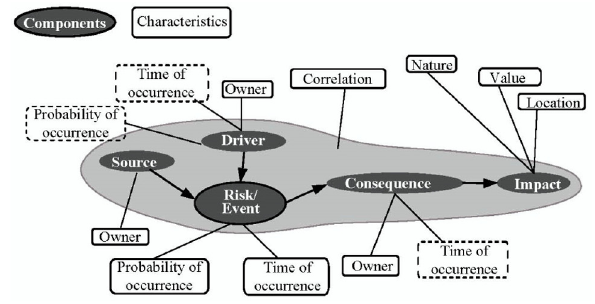
Fig. 2 . Components and characteristics of risk (Burcar, Radujković 2009)